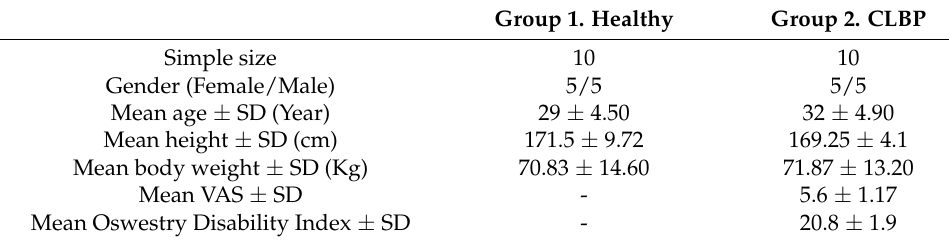
Table 1. The demographic information of the